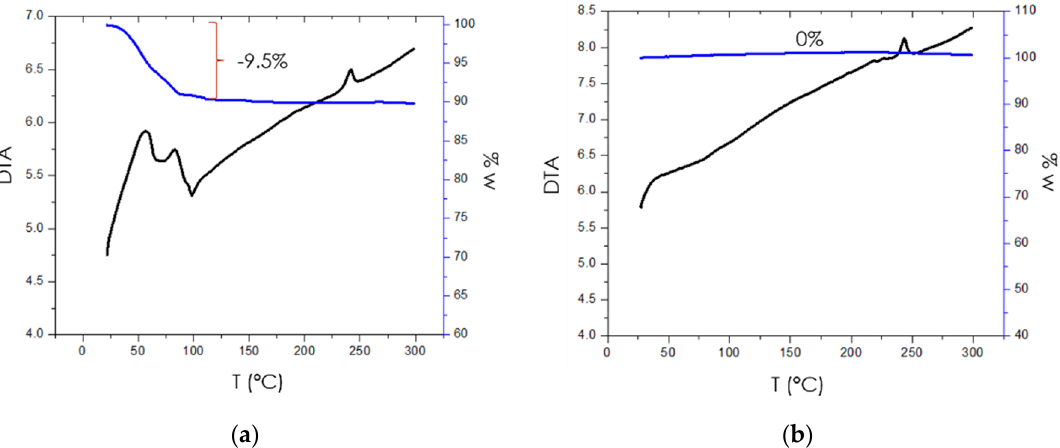
Figure 4. Thermogravimetric analysis. ( a ) 2 : [Eu(OOCC 6 H 5 ) 3 · (H 2 O) 3 ]; ( b ) 3 : [Eu(OOCC 6 H 5 ) 3 · (HOOCC 6 H 5 ) 2 ].